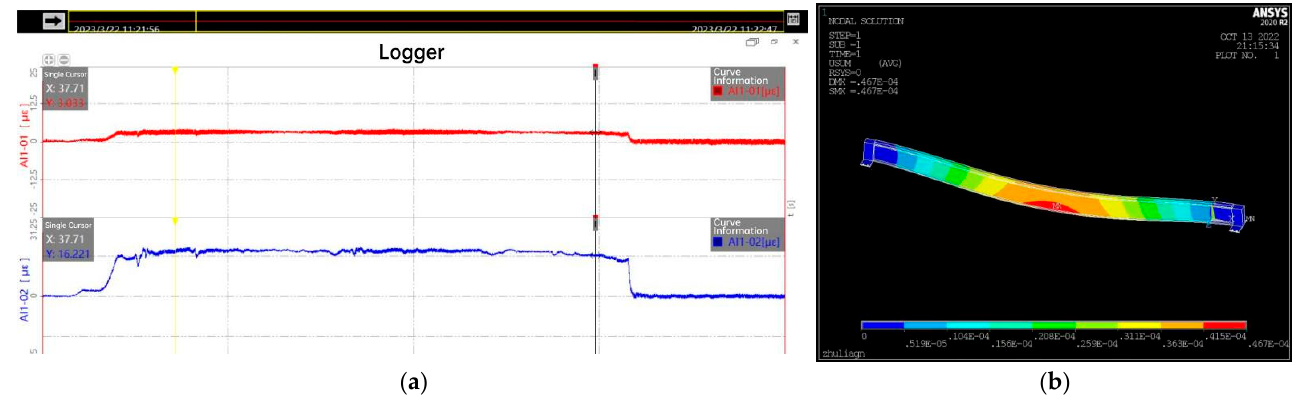
Figure 12. The stress–strain gauges for the crane.